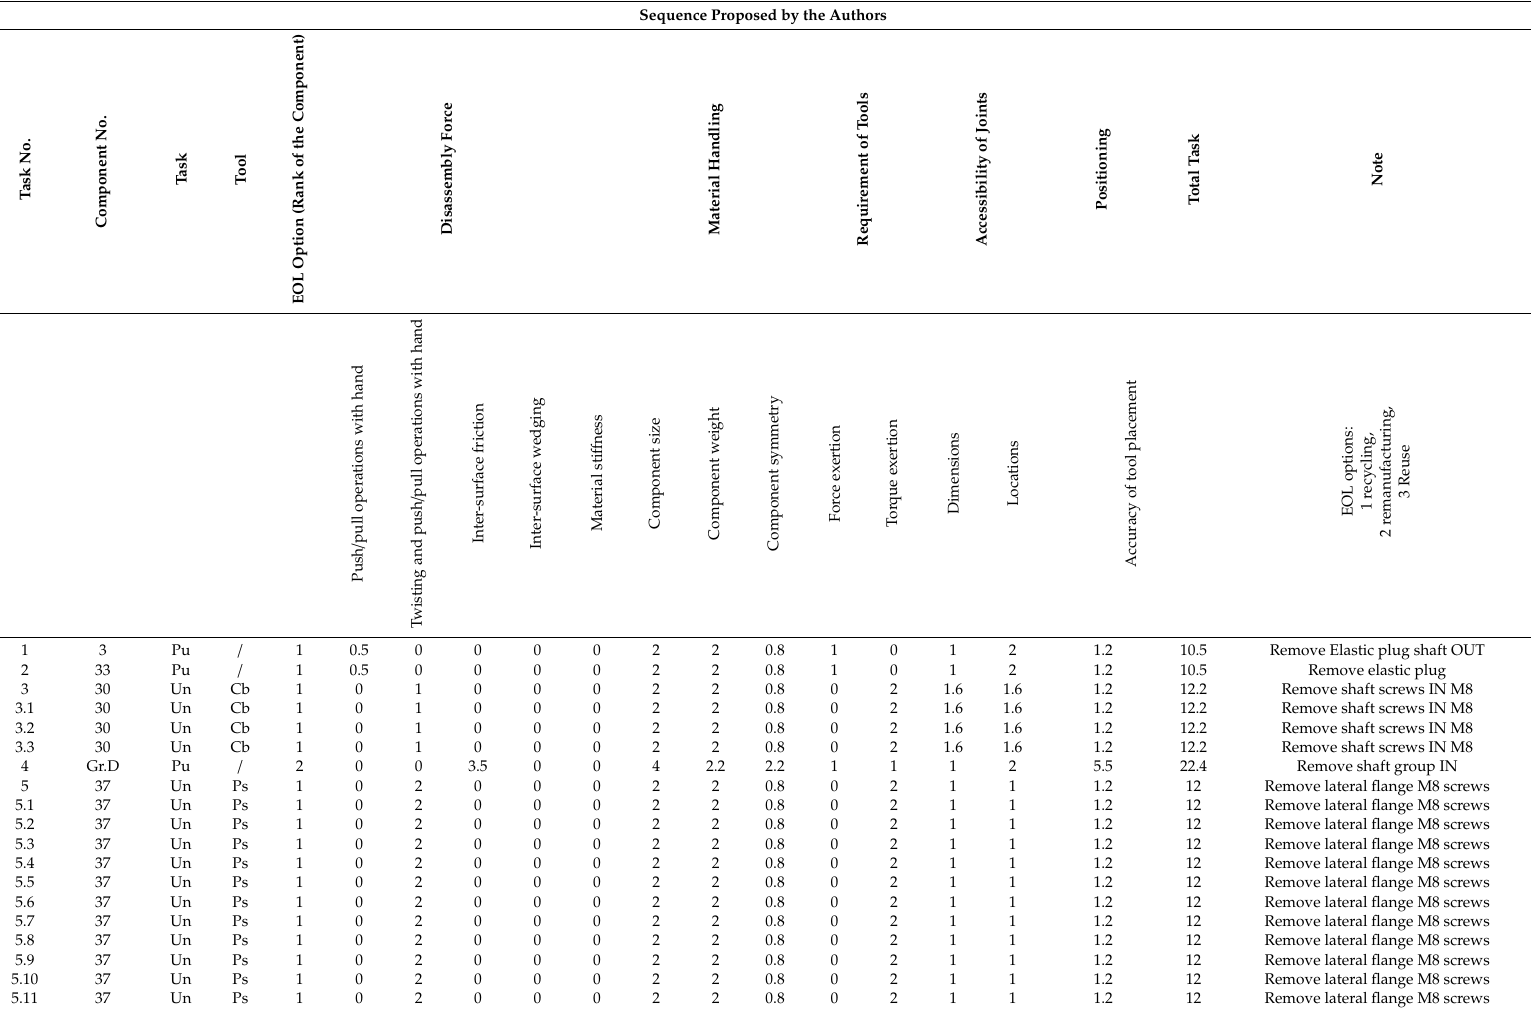
Table 3. The structure of data collection and the detail of disassembly operations completed following the sequence proposed by the current authors. Sequence Proposed by the Authors